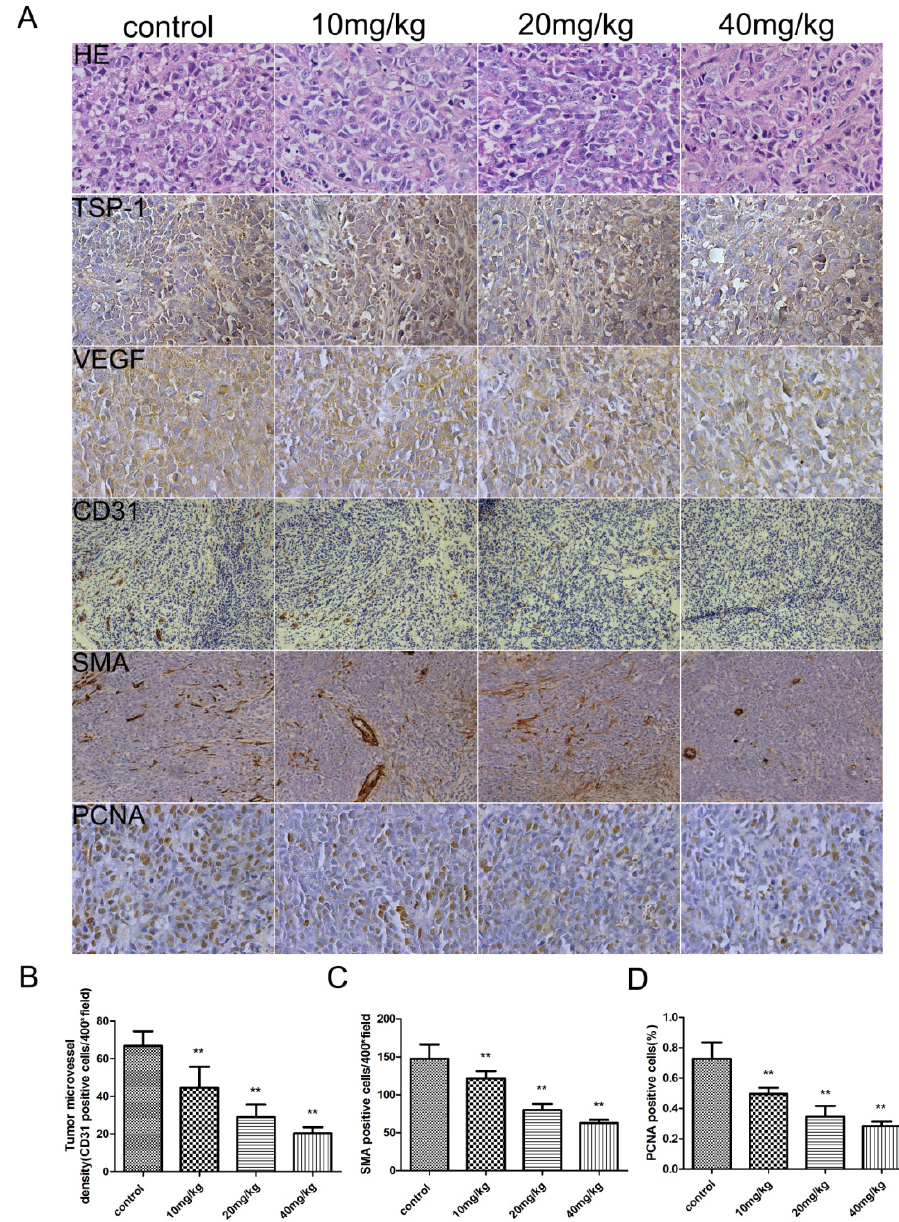
Figure 2. Immunohistochemical analysis of the effects of LQ on the angiogenesis of xenograft tumor. HeLa tumors were analyzed by hematoxylin-eosin staining and immunohistochemical staining for the expression of TSP-1,VEGF, CD31, SMA and PCNA ( A ). Microvessel density of the tumor tissues was assessed by CD31 and SMA immunohistochemical analysis ( B ). Anti-PCNA staining in tumor sections from each group, the percentage of PCNA-positive cells per 200 × field was accounted for as described in the methods ( C ). Data are mean  SD. ** p <0.01, vs.